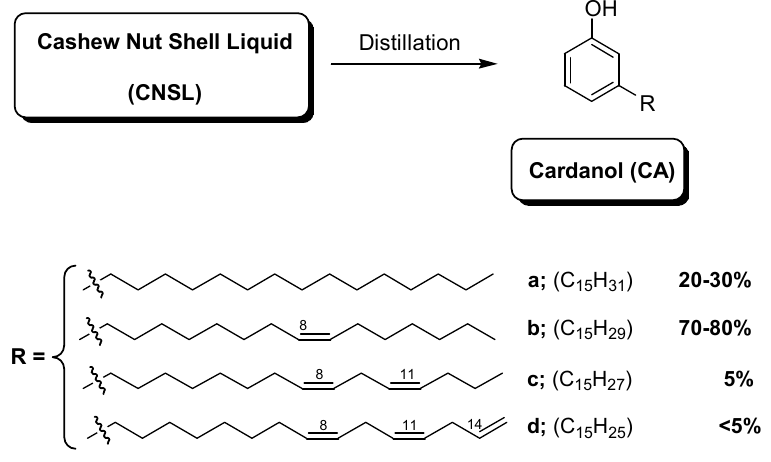
Figure 1. Molecular structure and composition of cardanol